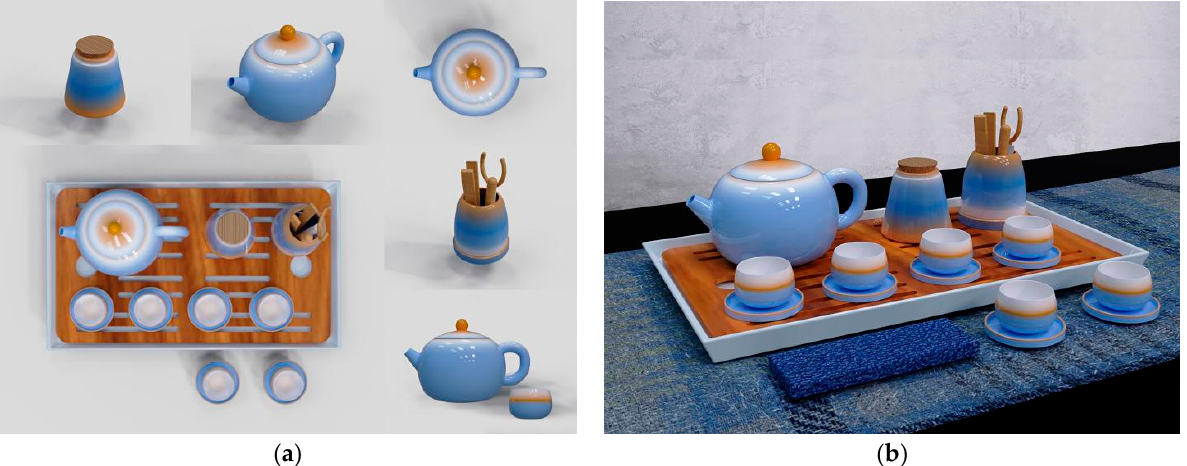
Figure 11. Tea set series product design scheme. ( a ) Single product model effect; ( b ) The overall effect of the series.